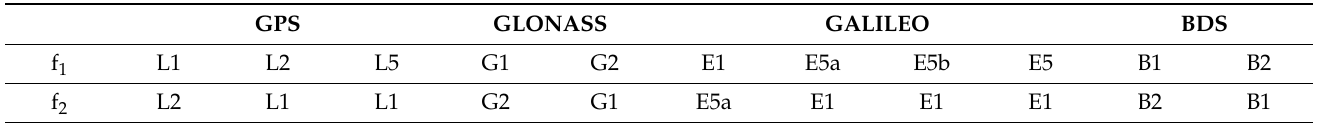
Table 2. Frequency pairing for pseudorange multipath